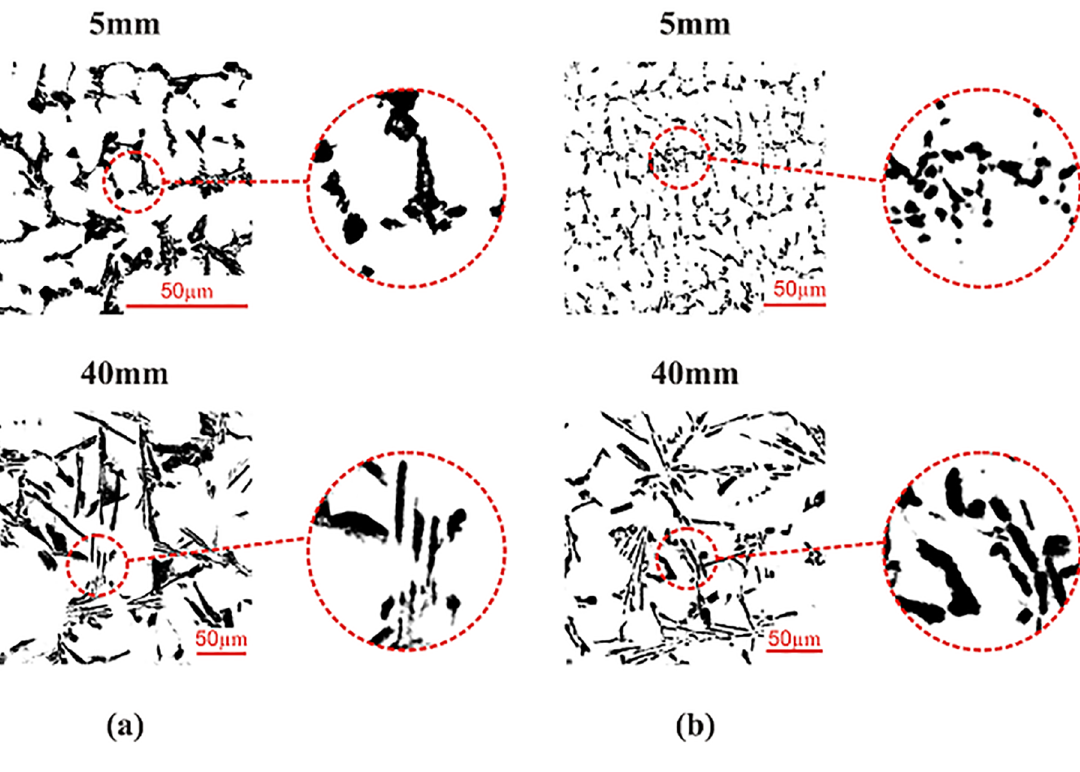
Figure 7. Typical microstructures of the as-cast and heat-treated samples. Si particle analysis in positions: (a) 5 mm and (b) 40mm, in relation to the metal/mold interface, respectively.